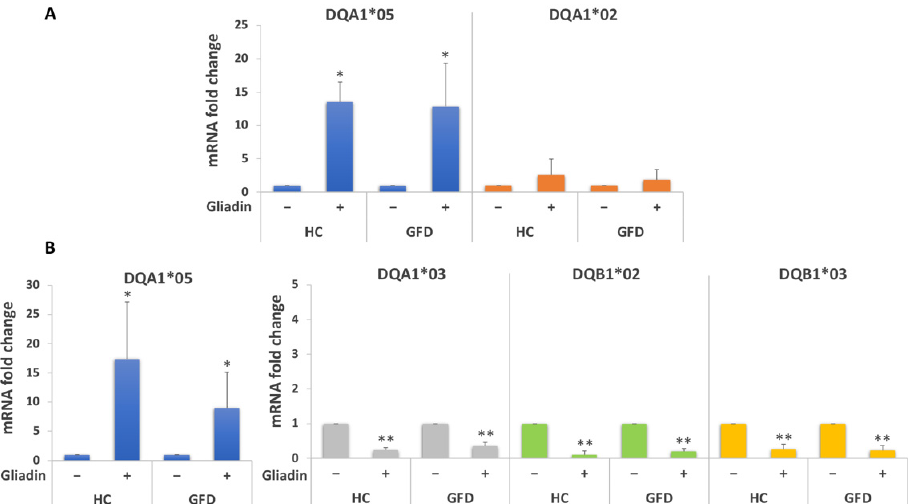
Figure 4. Analysis of DQ genes expression of macrophages from a U.S. cohort stimulated with gliadin. ( A ) DQA1*05 and DQA1*02 mRNAs fold variation in HC ( n = 3: FFL340, FFL665, and FFL329) and GFD patients ( n = 3: CHM144A, CHM150A, and CHM019A) with the DR3/DR7 genotype after overnight gliadin stimulation (* p < 0.05). ( B ) DQA1*05, DQA1*03, DQB1*02, and DQB1*03 mRNAs fold variation in HC ( n = 3: FFL605, FFL642, and FFL1119) and GFD patients ( n = 3: CHM13C, CHM88A, and FFL639) carrying the DR3/DR4 genotype after overnight gliadin stimulation (* p < 0.05, ** p < 0.01).